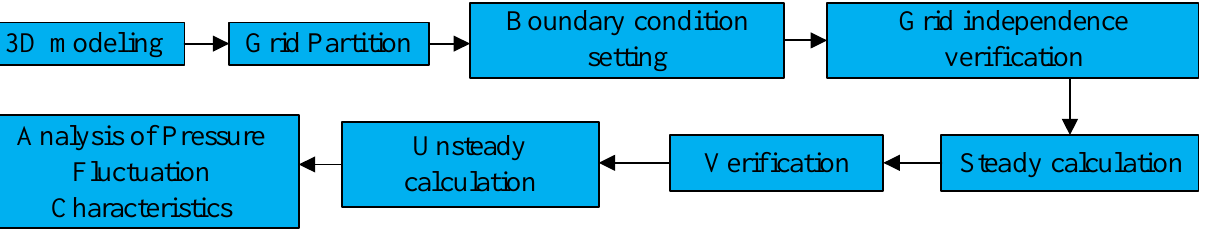
Figure 2. Flowchart of study process.